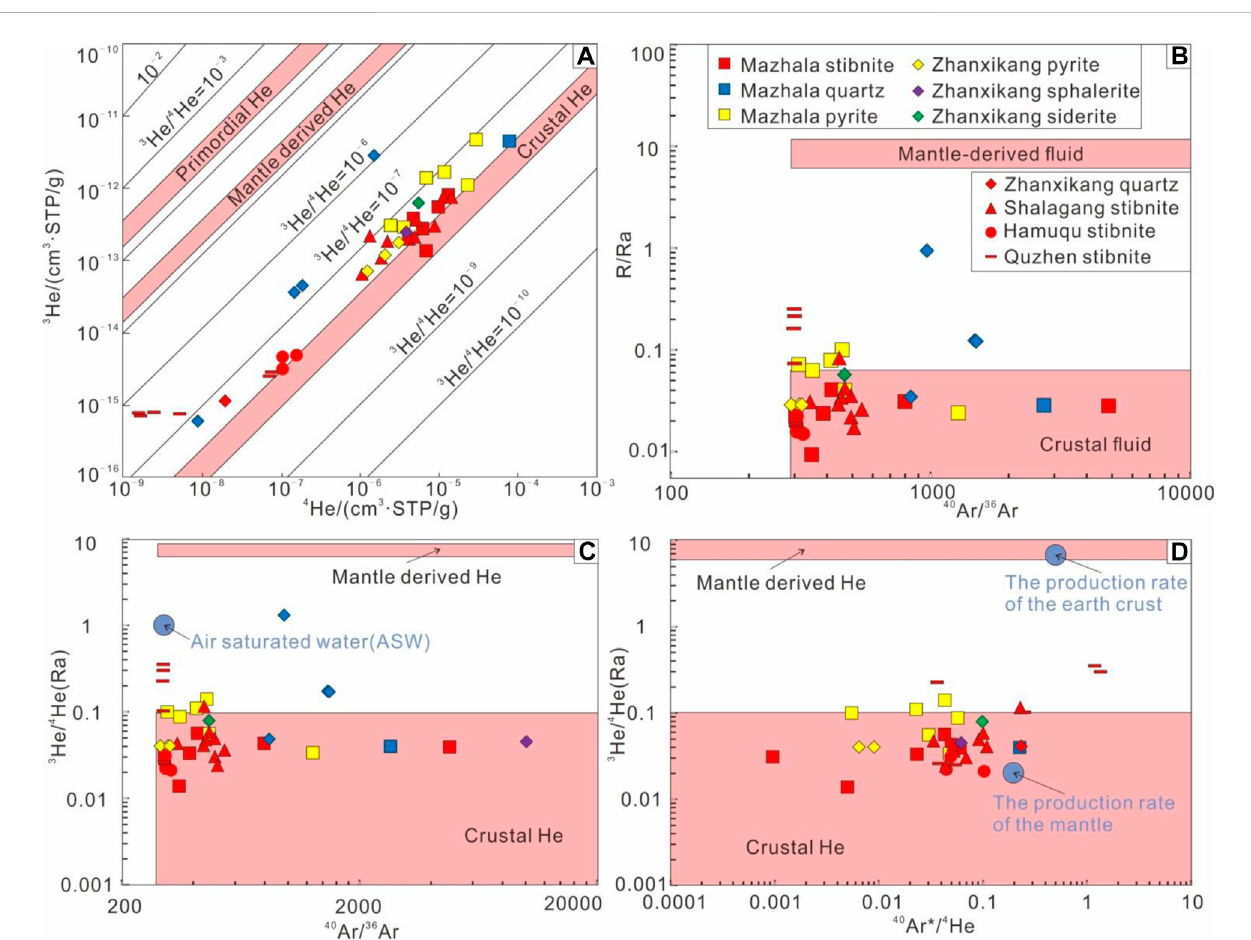
FIGURE 7 (A) plot of 4 He versus 3 He (basemap after Mamyrin and Tolstikhin, 1984); (B) plot of 40 Ar/ 36 Ar versus R/Ra (basemap after Burnard et al., 1999); (C) plot of 40 Ar/ 36 Arvs 3 He/ 4 He(Ra)(crustalandmantleHefromAndrews,1985;Stuartetal.,1994); (D) plotof 40 Ar*/ 4 Hevs 3 He/ 4 He(Ra)(crustalandmantleHeandHe,Ar isotope production rations from Andrews, 1985; Stuart et al., 1994).